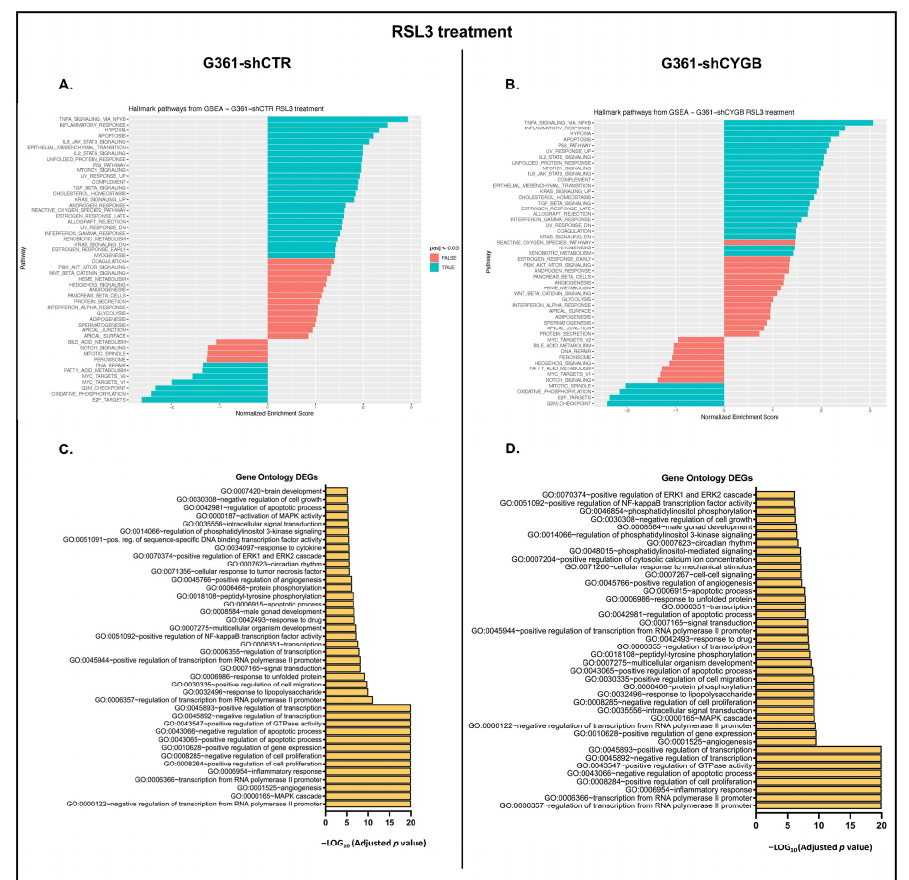
Figure 6. RSL3-mediated transcriptomic changes. Analysis of the transcriptomic changes induced by RSL3 treatment in G361-shCTR and G361-shCYGB cells compared to the untreated control. ( A , B ) fast Gene Set Enrichment Analysis (fGSEA) using the hallmark pathway gene sets was per- formed on G361-shCTR ( A ) and G361-shCYGB ( B ) melanoma cells. Gene ontology (GO) enrichment analysis was performed on the significantly differentially expressed genes (DEGs) in G361-shCTR ( C ) and G361-shCYGB ( D )